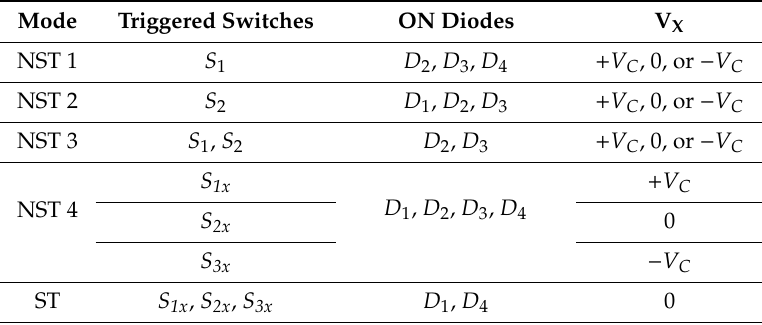
Figure 2. Modes of the quasi-switched boost T-type inverter (qSBT 2 I). ( a ) NST 1, ( b ) NST 2, ( c ) NST 3, ( d ) NST 4, ( e ) shoot-through (ST). Table 1. Switching states of qSBT 2 I ( x = a , b , and c ).